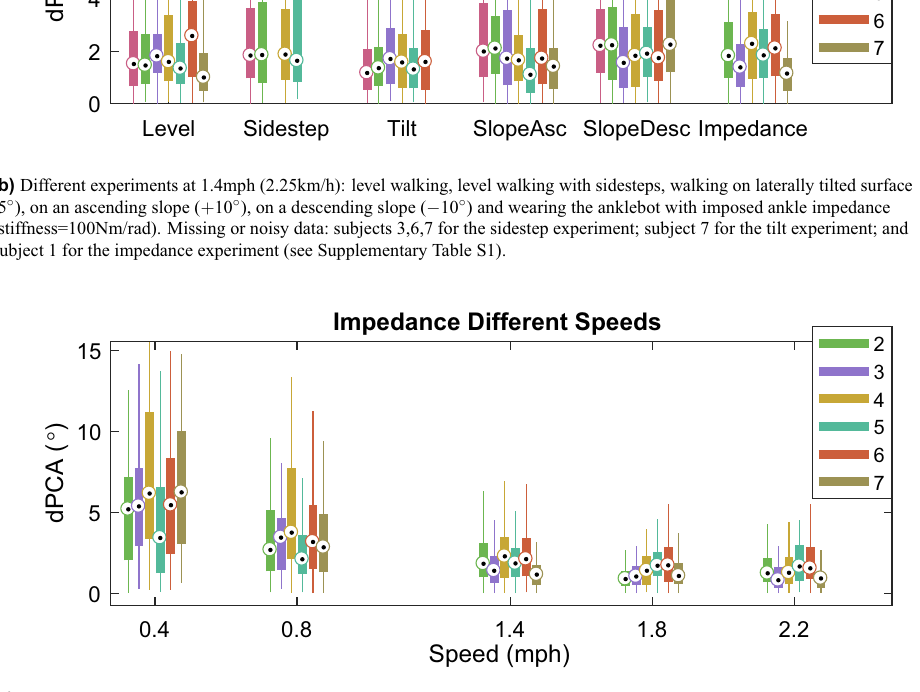
Figure 4. Box-plots of difference in angle between principal component of consecutive orbits (dPCA) for each